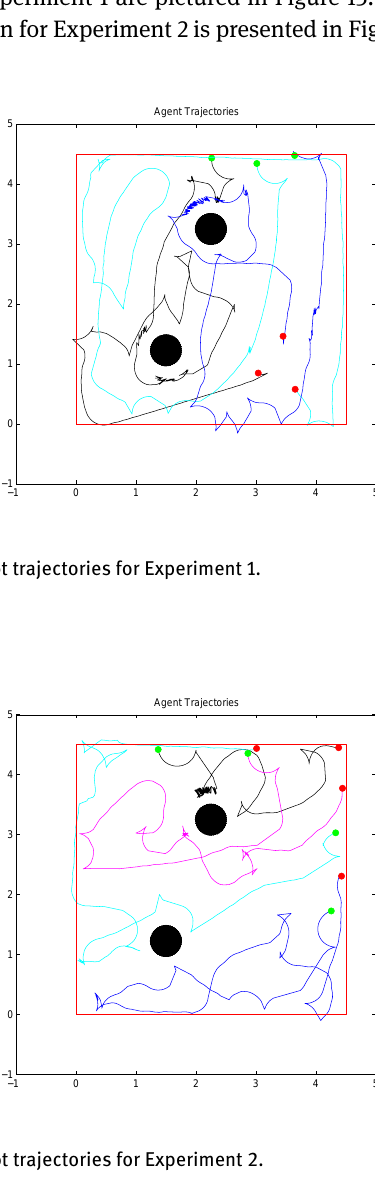
Fig. 14. Robot trajectories for Experiment 2.